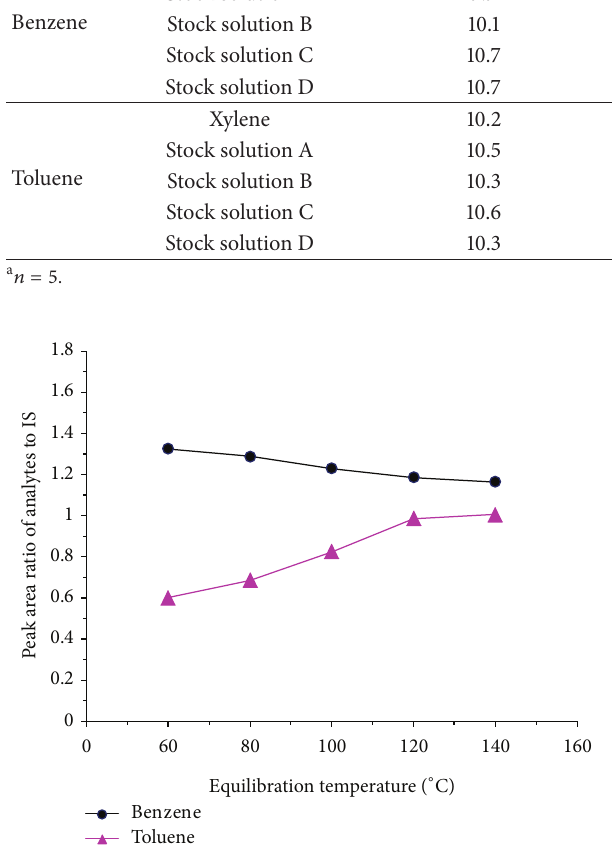
Figure 3: Effect of equilibration temperature on the peak area ratios of benzene and toluene to IS (equilibration time: 10min).